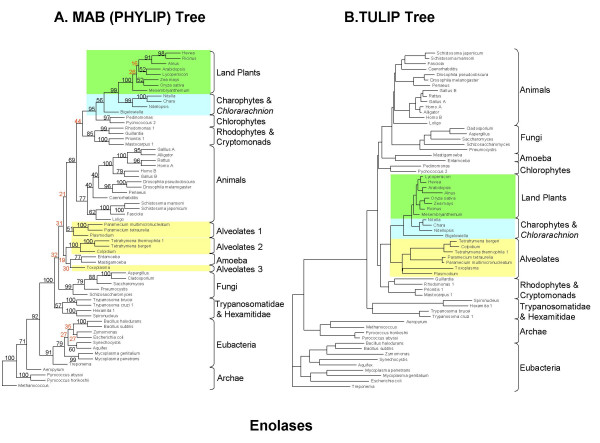
Solution of the enolase phylogenic incongruence. (A) Multiple alignment based (MAB) tree. (B) TULIP tree. Both trees were constructed using the BLOSUM 62 similarity matrix. For MAB tree construction, bootstrap support was estimated using 1000 replicates. To build TULIP trees, Z-scores were estimated with 2000 sequence shuffling. Clades that contain a unique insertional signature (Land plants, green box; Charophytes and Chlorarachnion, blue box; Alveolates; yellow box) are not gathered in the MAB tree, as previously reported [36]. By contrast, in the TULIP tree, the phylogeny of enolase proteins is reconciled with the insertional signature detection in Land plants, Charophytes, Chlorarachnion and Alveolates.